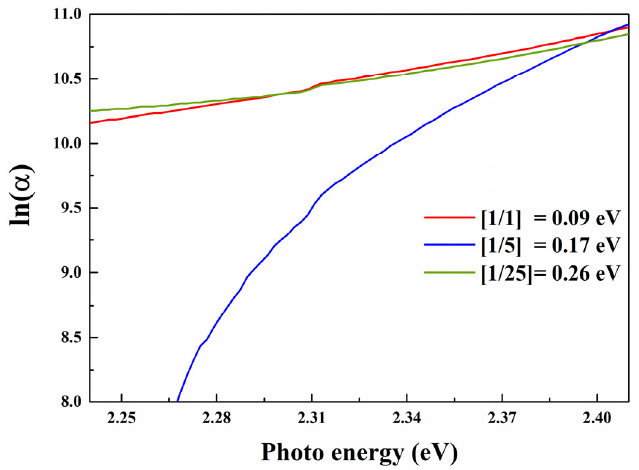
Figure 5. Urbach energy of Cd/S films.